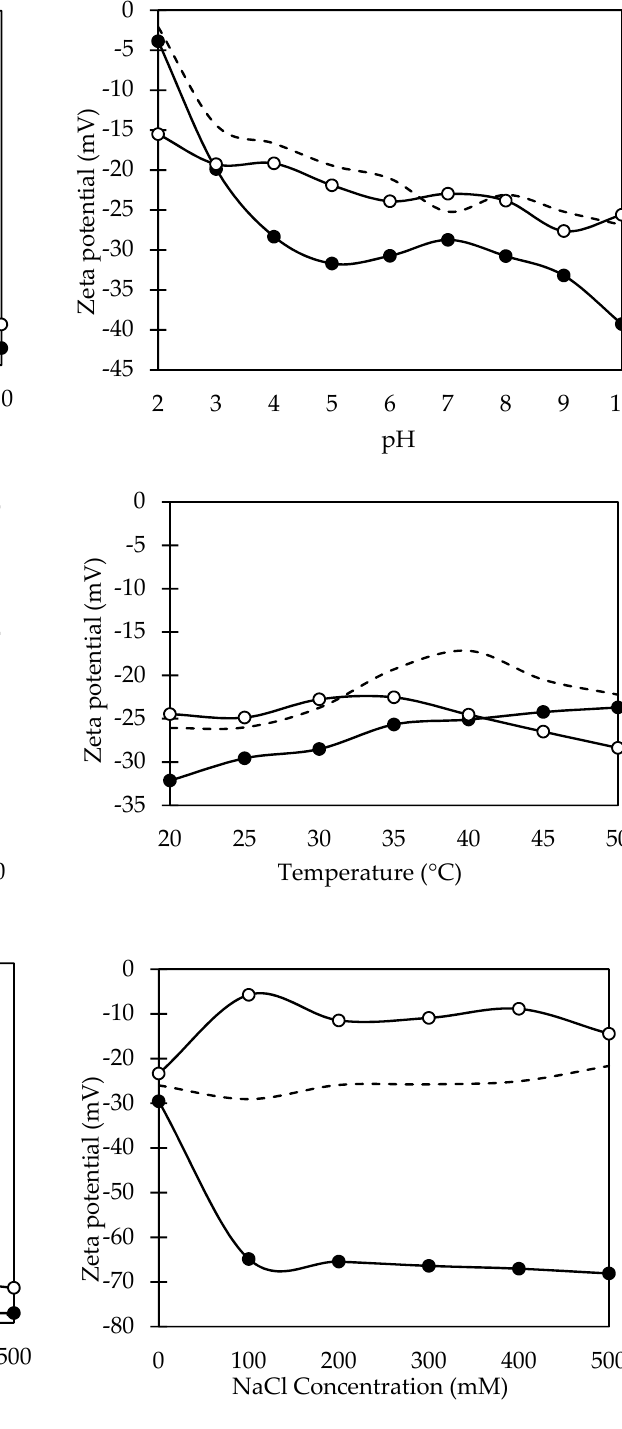
Tween 20 emulsions were destabilized at pH 2, while C. quinoa emulsions were destabilized at pH 2 and 3 (Figure 2a).